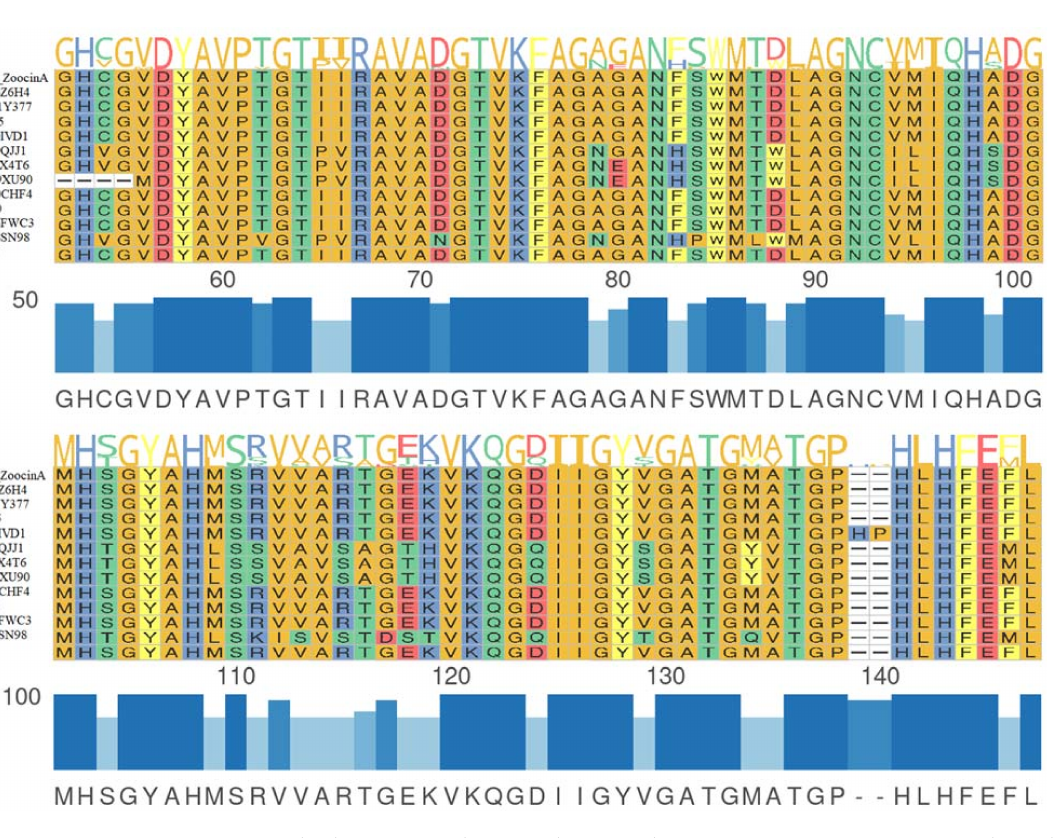
Figure 3. Multiple sequence alignment between the LGMAI’s putative zoocin A and 12 other zoocin A sequences obtained from the Uniprot database. Amino acid conservation can be observed in the M23 peptidase domain. Protein sequence logos are at the top of the representation, while multiple sequence alignments are in the middle, and the identity bars and consensus sequences are at the